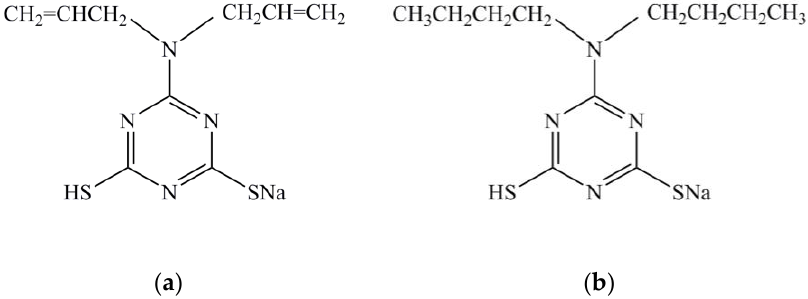
Figure 1. Molecule structures of two triazinedithiols of ( a ) 6-diallylamino-1,3,5-triazine-2,4-dithiol monosodium (DAN) and ( b ) 6-dibutylamino-1,3,5-triazine-2,4-dithiol monosodium (DBN).